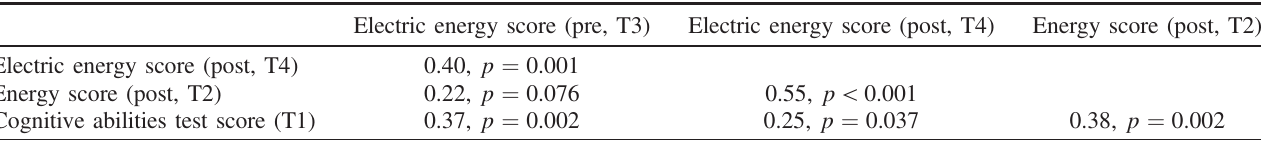
TABLE III. Correlations between all